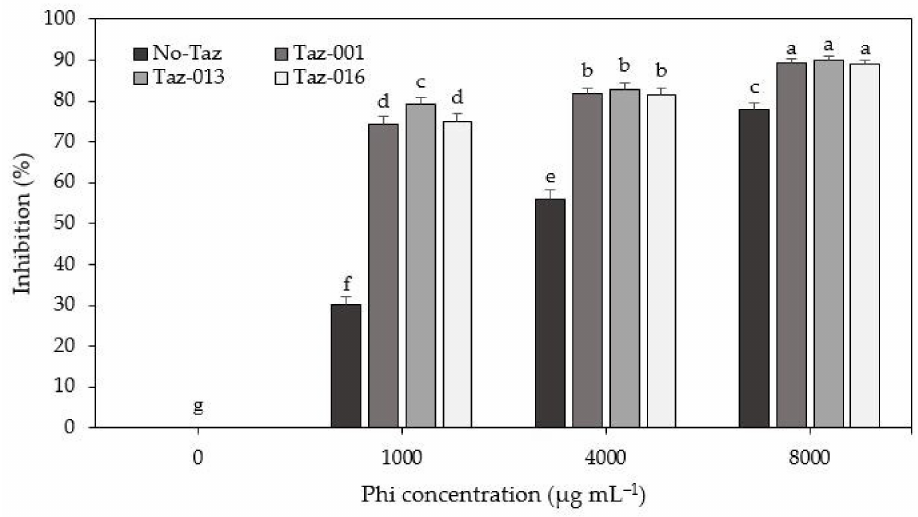
Figure 4. Mycelial growth inhibition (MGI) of Fusarium sp. with Trichoderma sp. (Taz-001, Taz-013, and Taz-016) and adding Phi to the culture medium. Means ± SD with different letters are statistically different (Fisher’s test; α =